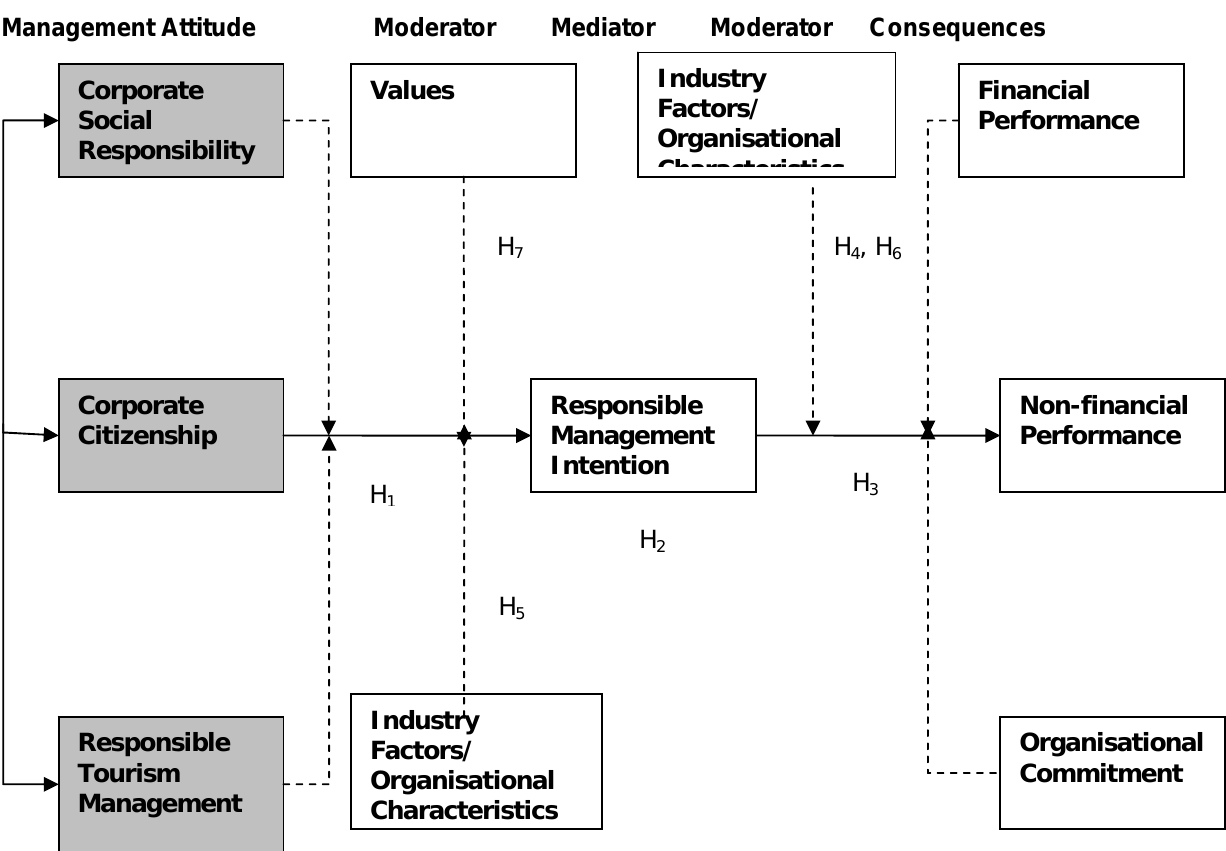
Figure 1: Conceptual framework of the effect of management attitude on performance. Table 3: Cronbach’s alpha reliability scores